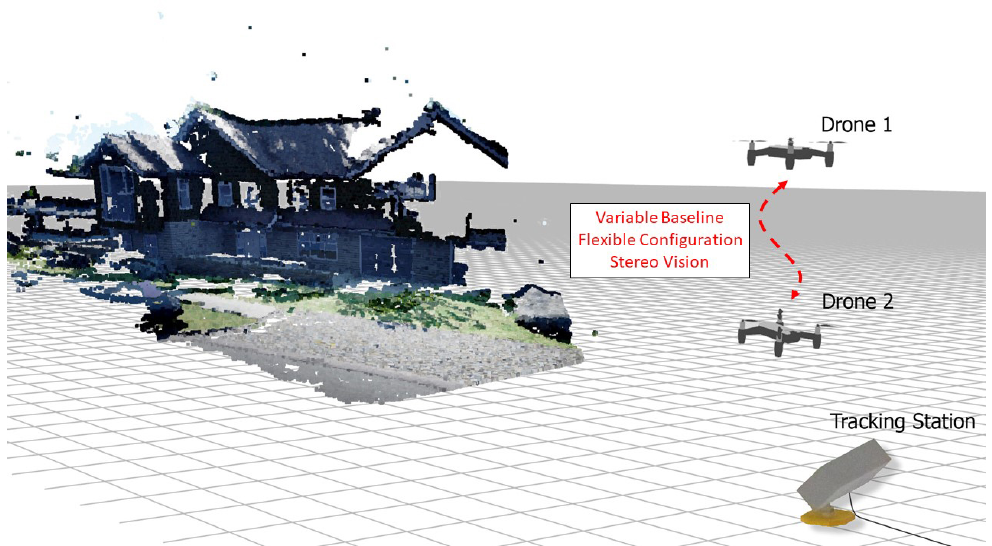
Figure 1. Graphical render of proposed system, where two drones are used as the reconnaissance agents for 3D map creation. A ground-tracking device is used for